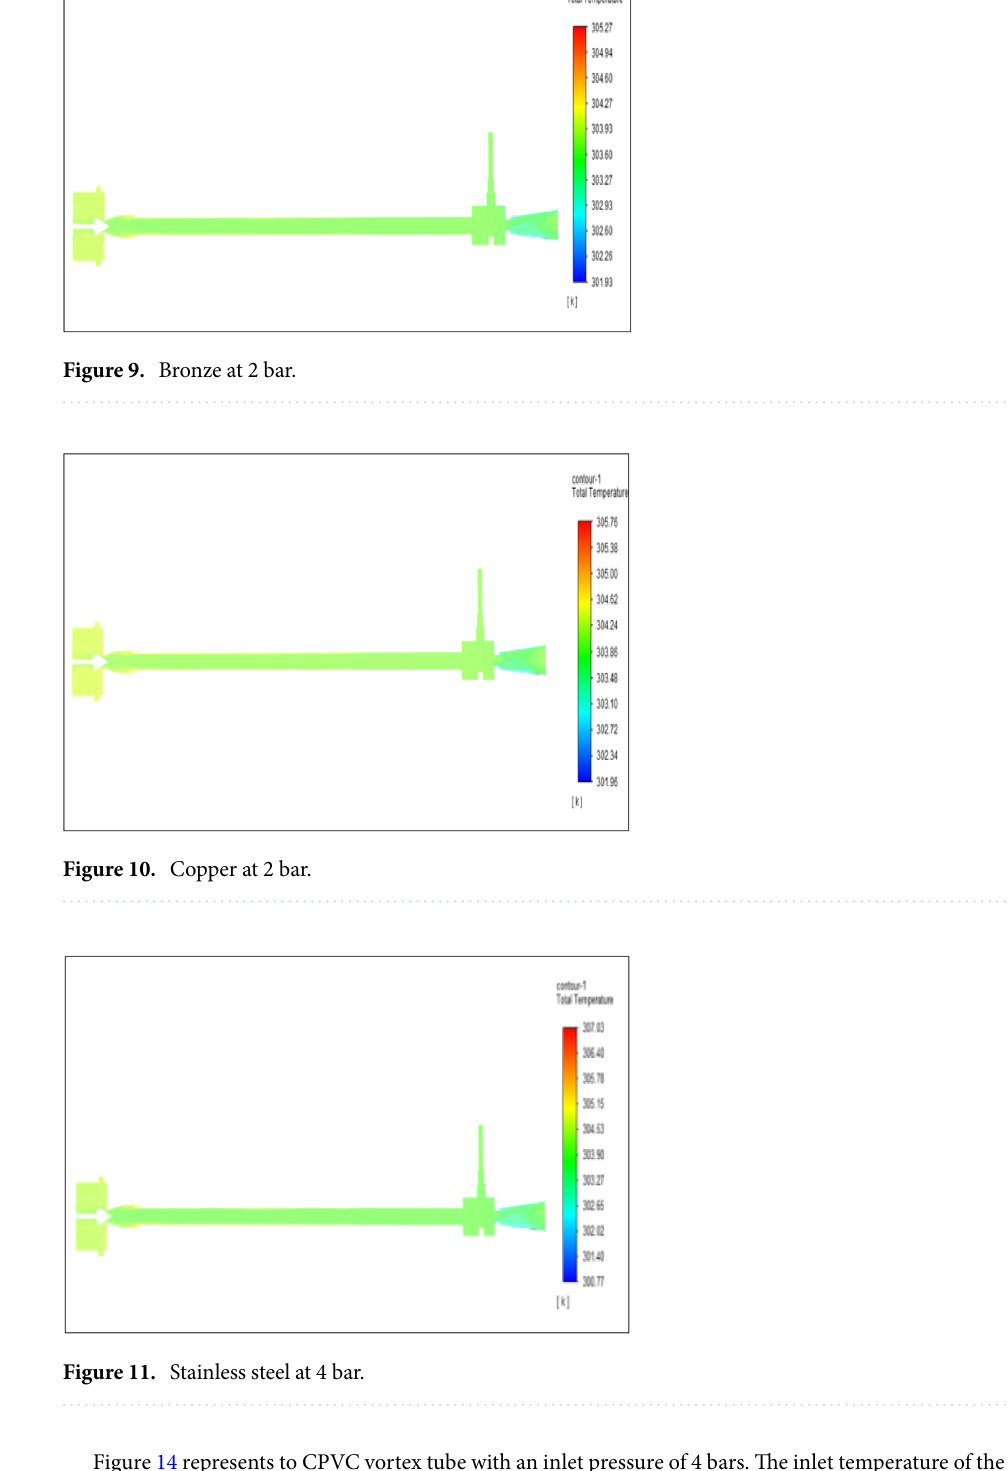
Figure 14 represents to CPVC vortex tube with an inlet pressure of 4 bars. The inlet temperature of the VT is 303 K. The hot air temperature was obtained at the hot end as 306.06 K. Similarly, the cold end side obtained a value of 300.86 K. The maximum temperature difference was found to be 5.21 K. Figure 15 represents to acraulic vortex tube with an inlet pressure of 4 bars. The inlet temperature of the VT is 303 K. The hot air temperature was obtained at the hot end as 306.61 K. Similarly at cold end side obtained a value of 301.39 K. The maximum temperature difference was found to be at 5.23 K.